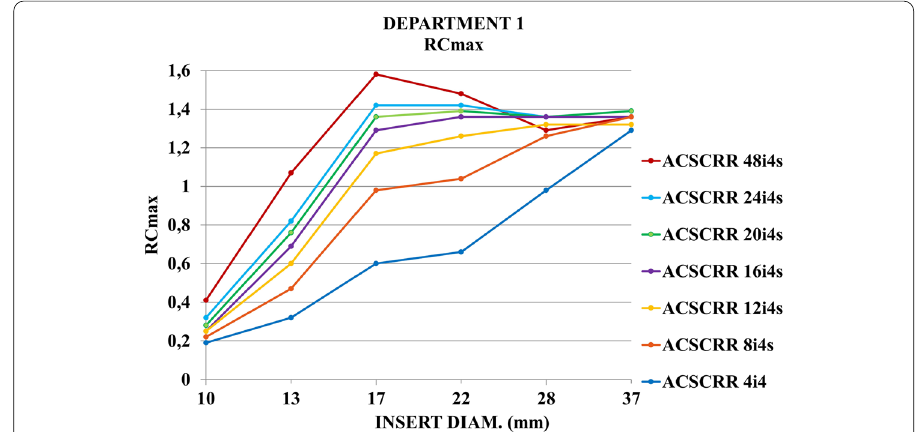
Fig. 7 Recovery coefficients (RC max ) for activity concentration in 6 spherical inserts of the NEMA/IEC NU2 Body Phantom scanned with Discovery NM/CT 670 gamma camera